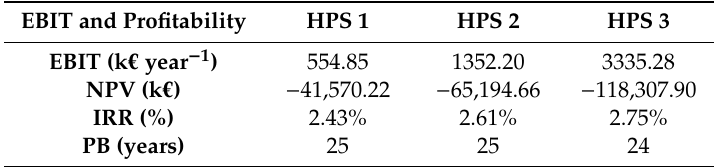
Table 3. Profitability analysis of HPS 1, HPS 2 and HPS 3, considering the construction of new tunnels or caverns, DTCs of 8 h and a lifetime of 35 years.